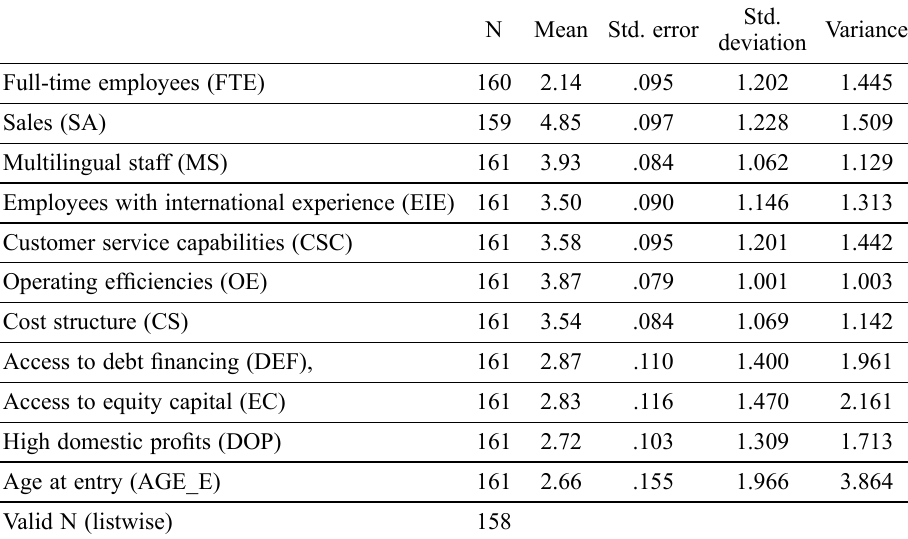
Table 6. Descriptive statistics for all variables used in the study N Mean Std.